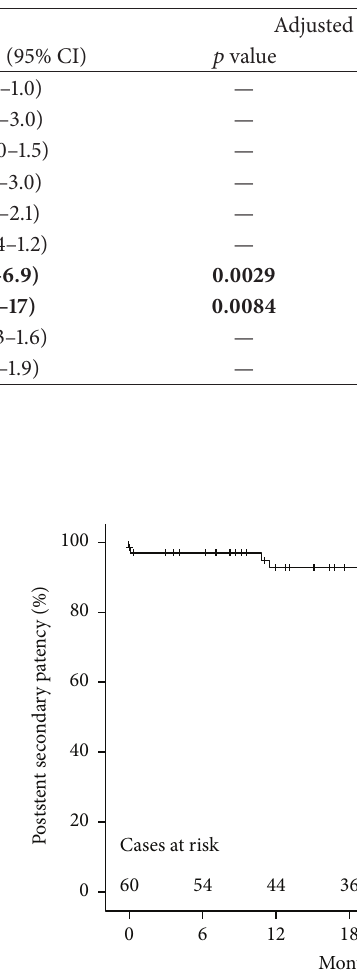
Table 3: Predictors of postintervention primary patency after stent insertion.